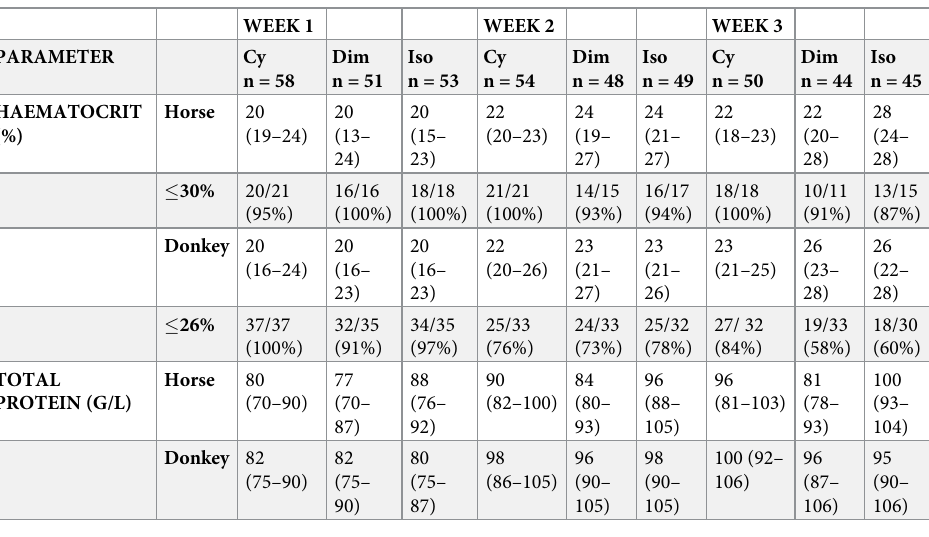
Table 3. Clinicopathological